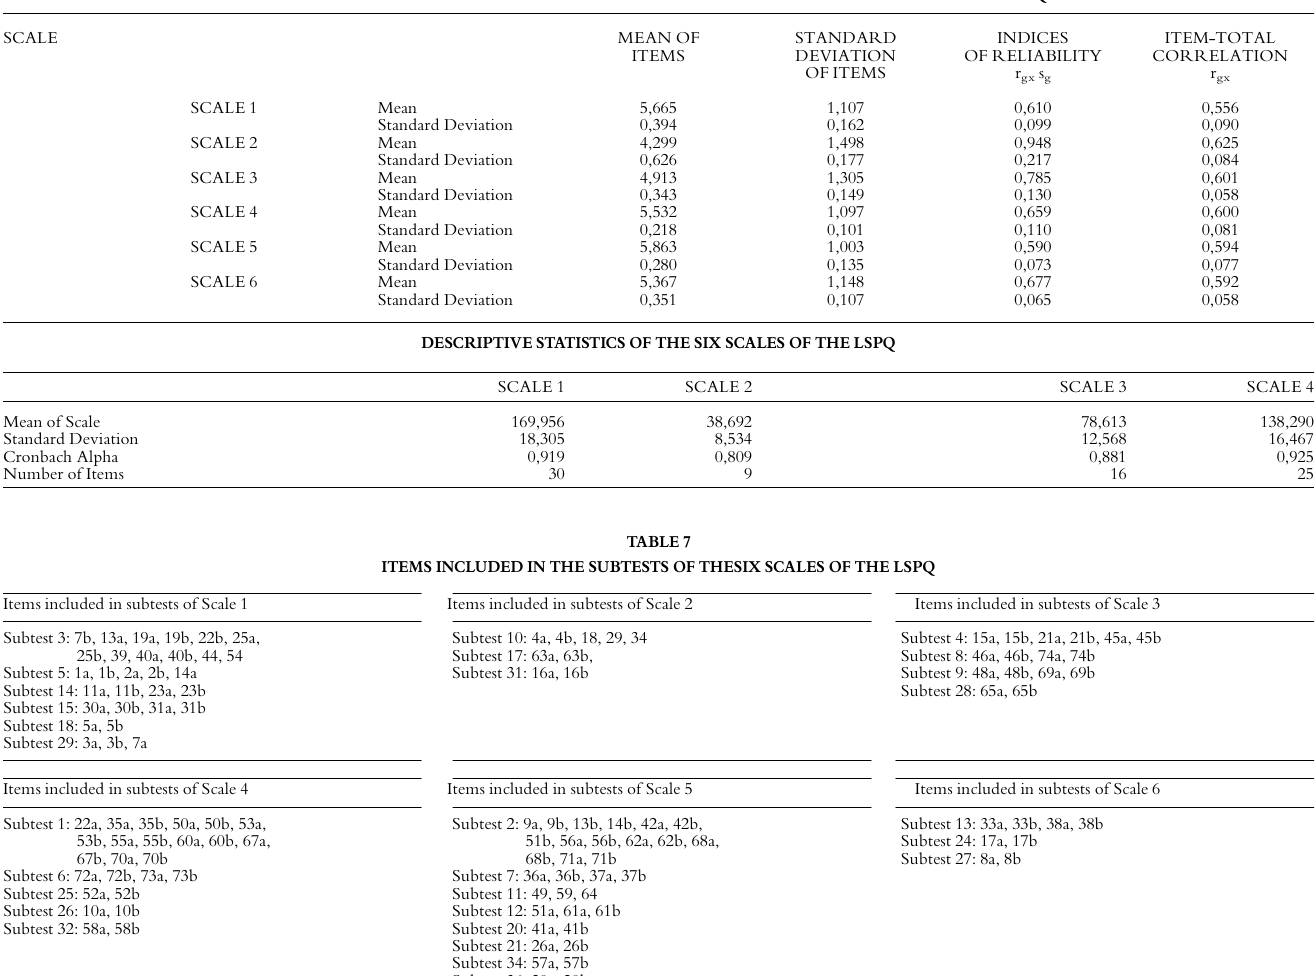
TABLE 6 MEANSANDSTANDARDDEVIATIONSOF THE ITEM STATISTICSOF THESIXSCALESOF THELSPQ